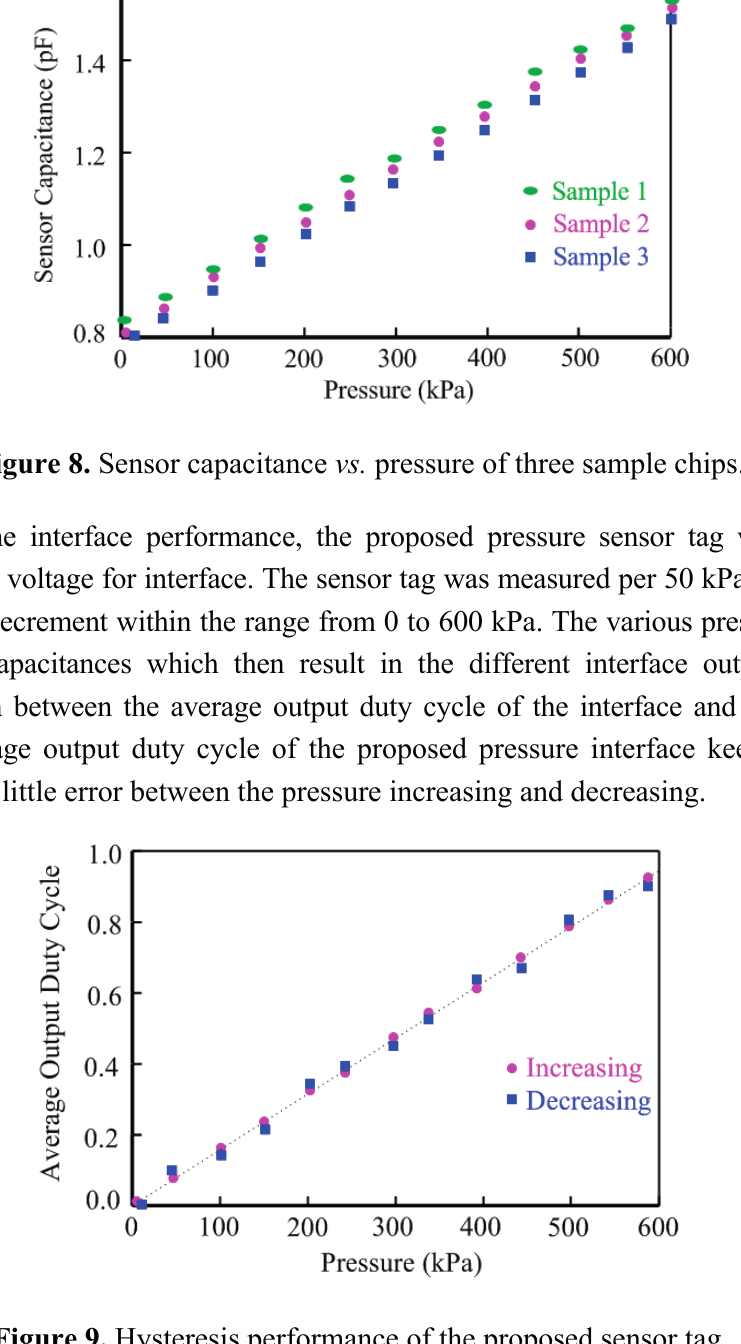
Figure 9. Hysteresis performance of the proposed sensor